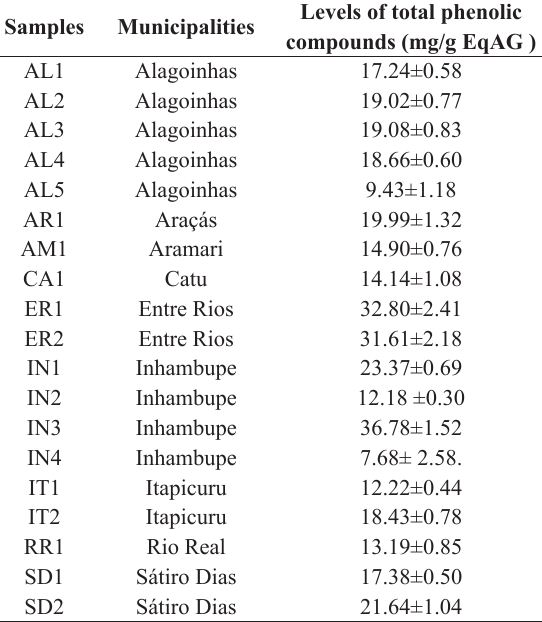
Levels of total phenolic compounds found in the analyzed propolis samples from the municipalities of the territory of the Agreste of Alagoinhas.